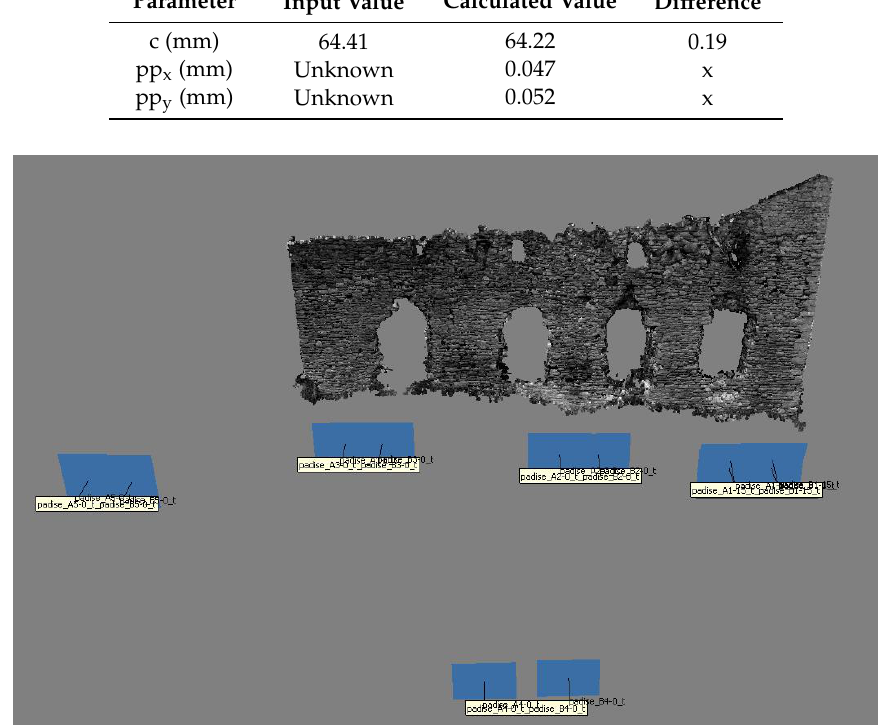
Figure 6. Resulted point cloud of the south wall created by re-processing with relative position of captured images.